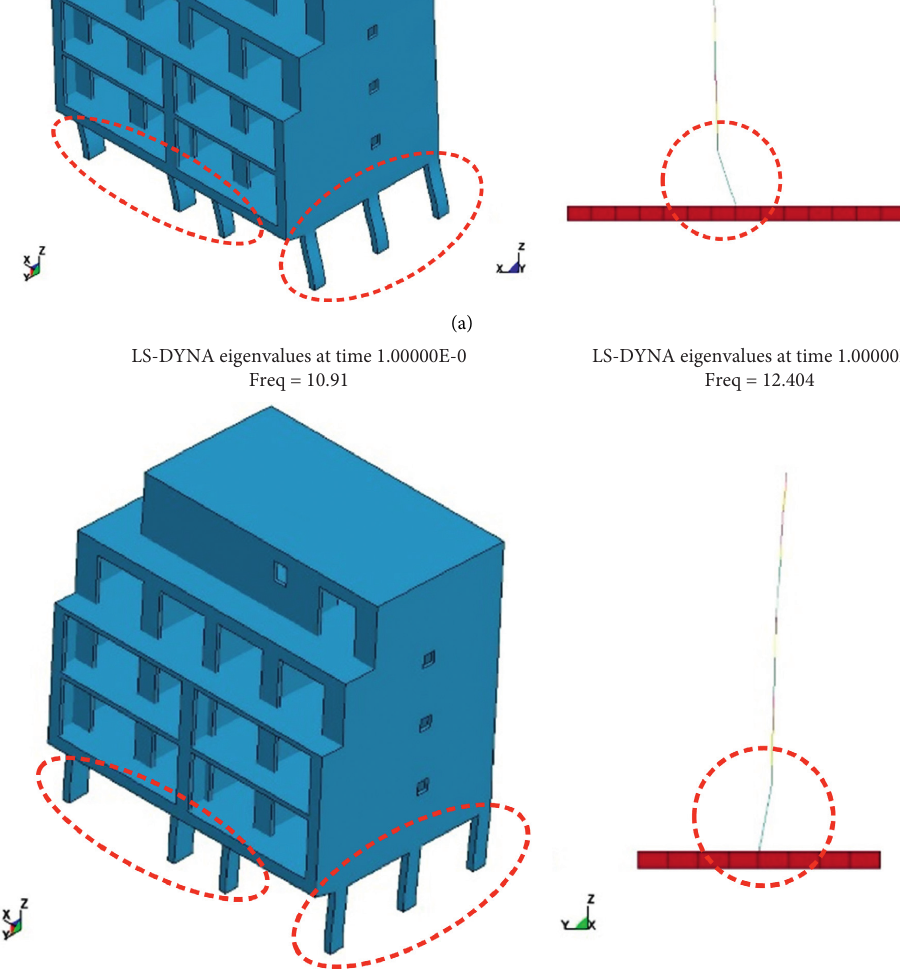
Figure 5: Fundamental transverse mode shapes of the full and lumped mass models in each direction. (a) EW direction ( X -axis). (b) NS direction ( Y